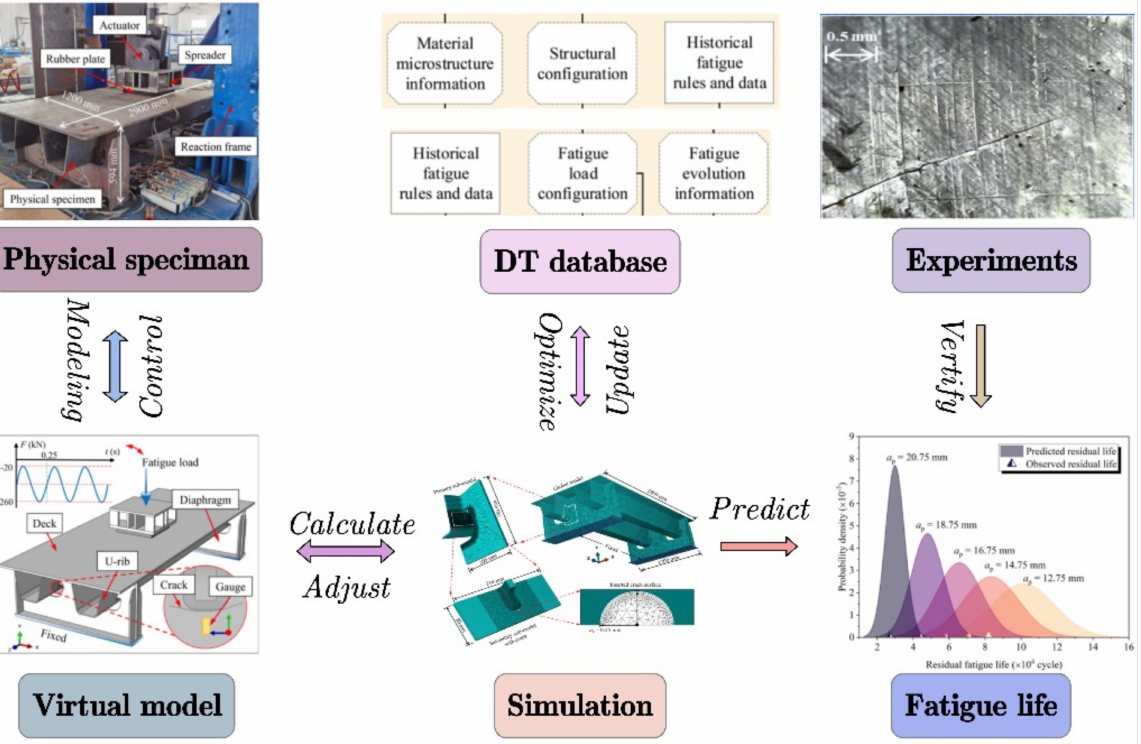
Figure 15. DT-driven framework for non-deterministic fatigue life prediction of steel bridges